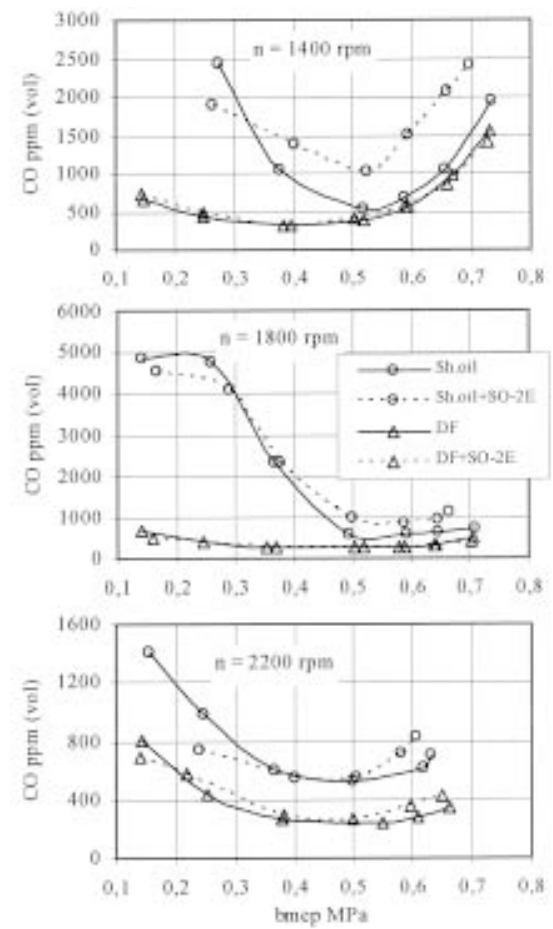
Fig 3. Carbon monoxide CO emissions in the exhausts as a function of engine load (bmep) at various revolution